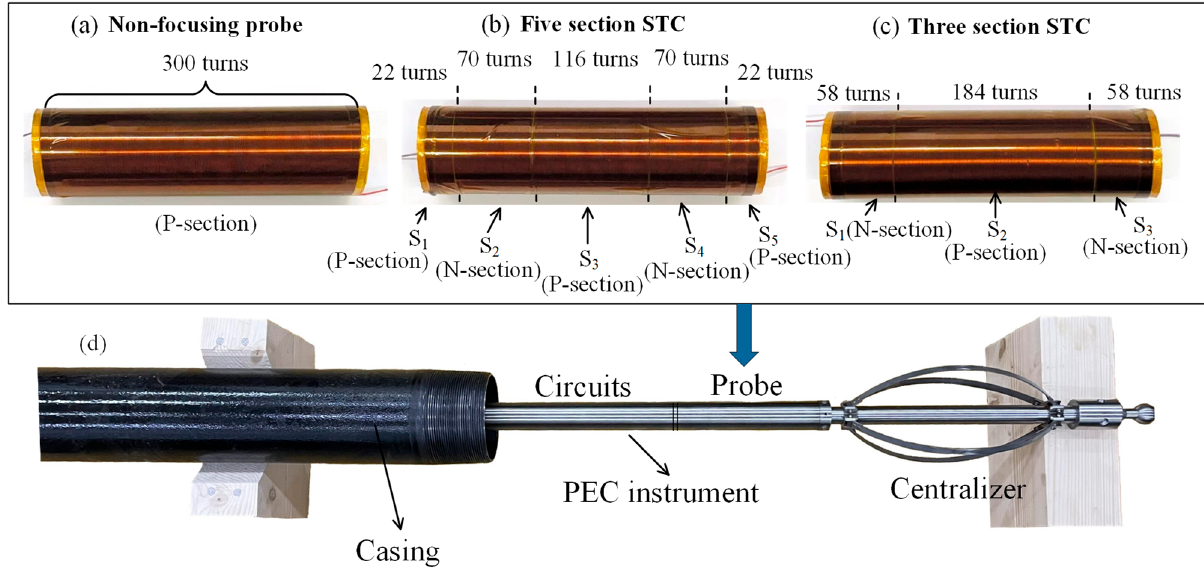
Figure 7. Probe structures and PEC inspection system for the experiments: ( a ) non-focusing probe structure; ( b ) five-section STC probe; ( c ) three-section STC probe; and ( d ) the PEC inspection sys- tem .